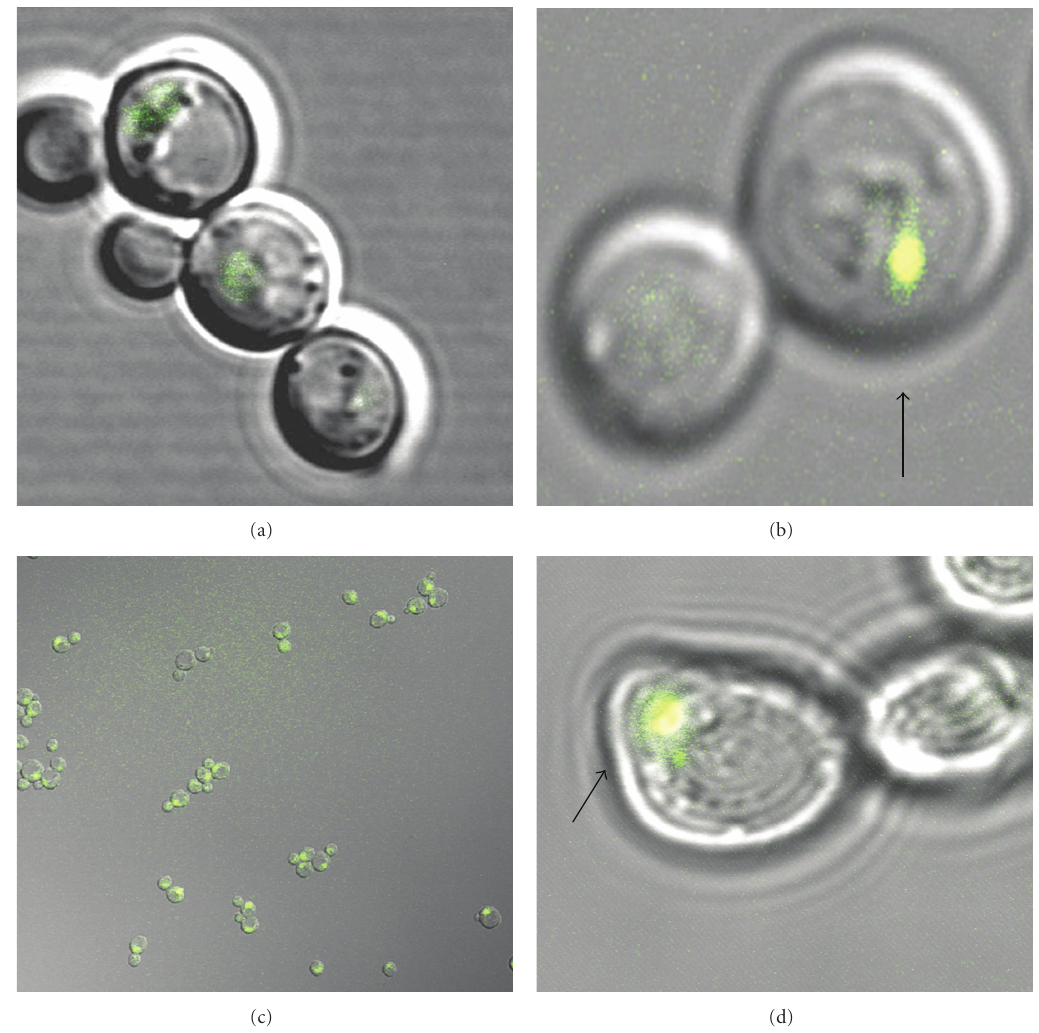
Figure 2: Confocal imaging of Rad51-YFP foci in live AFB 1 -exposed yeast cells. (a) Control, no AFB 1 exposure, (b) Rad51-foci after exposure to X-rays, (c) Rad51 foci in logarithmically growing cells exposed to 50 μ M AFB 1 , wide view, and (d) Rad51 focus in a synchronized cell after alpha factor arrest and exposure to AFB 1 .